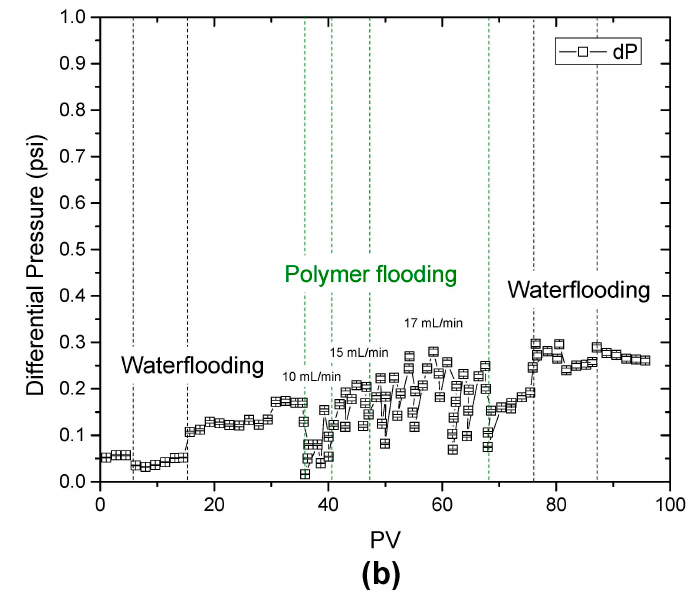
Figure 2. Injectivity test of the Scleroglucan (935 mgL − 1 ) in ( a ) 2155 mD, and ( b ) 4555 mD permeability from the representative formation at confining pressure 3100 psi, 212 °F and pore pressure of 600 psi. The dotted lines indicate the flow range at 10, 15, and 17 mL/min.